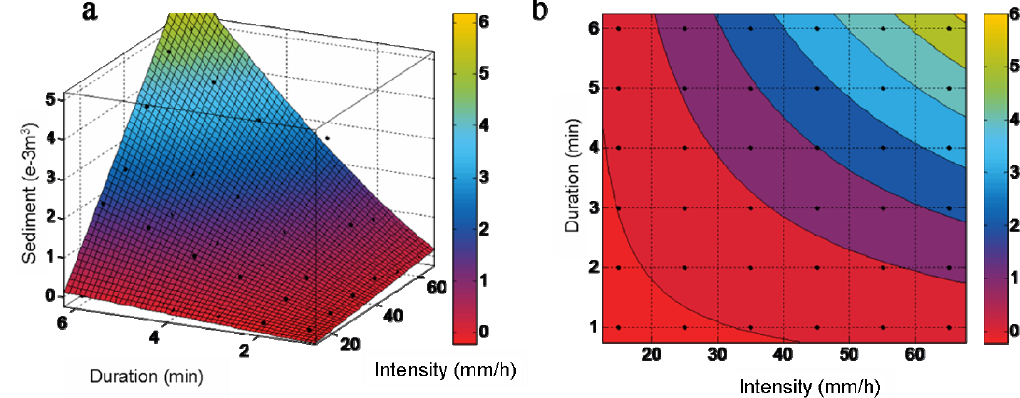
Figure 9. 3D fitting curve (rainfall intensity (mm/h), rainfall duration (min), and sediment (e-3m 3 ). ( a ) Optimum 3D fitting curve; ( b ) shadow map of optimum 3D fitting curve.